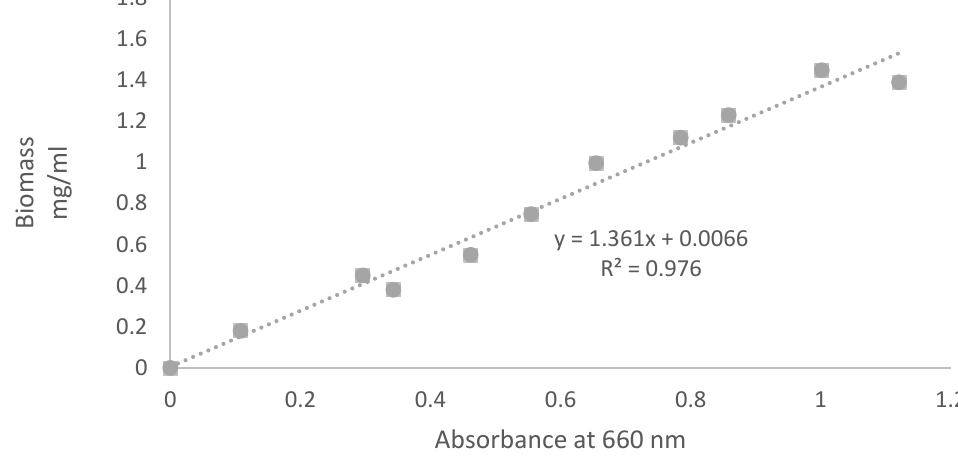
y = 1.361x + 0.0066 R² = 0.976